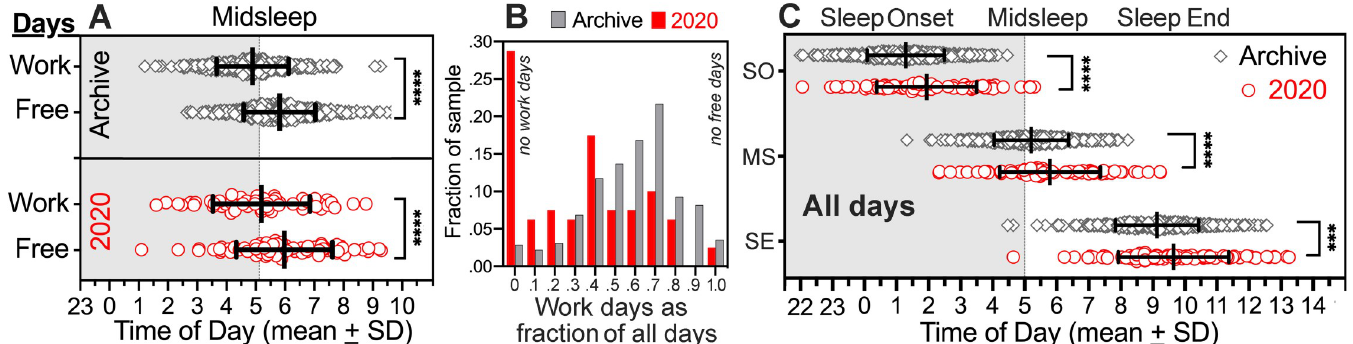
Fig 2. Sleep timing (diary data) on work, free and all days in the archive group (grey diamonds; N = 452) and the 2020 group (red circles; N = 80). [A]. Midsleep on work days (MSW) and on free days (MSFsc, sleep corrected). [B]. Frequency distributions of work days as a fraction of all days in the archive group (grey shaded bars) and the 2020 group (red open bars). The 0 bin denotes no work days, and the 1.0 bin denotes no free days. [C]. Sleep onset (SO), midsleep (MS, not sleep corrected) and sleep end (SE) averages for individual subjects across all days (bars denote group means ± standard deviation). ANOVA with Sidak multiple comparisons tests. ���� p � .0002, ��� p =